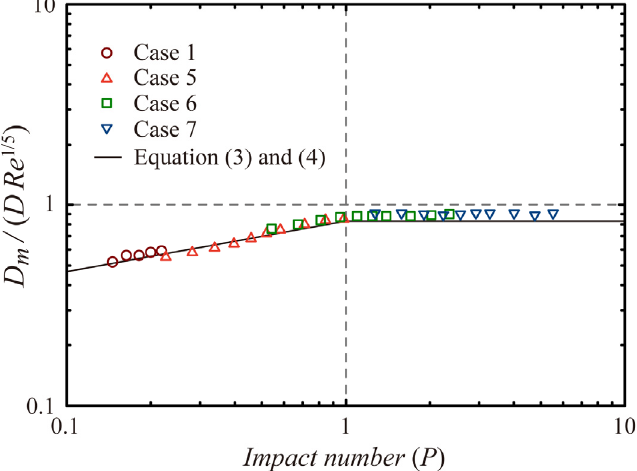
Figure 1. Validation of the numerical model based on the maximum spreading diameter ( D m ) of the spherical drop for viscous drop impact on non-wettable flat surfaces.